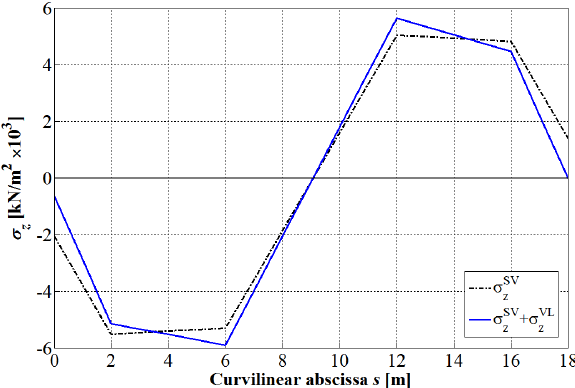
Figure 15: Axial stresses due to horizontal loads acting on open shear wall no. 6.